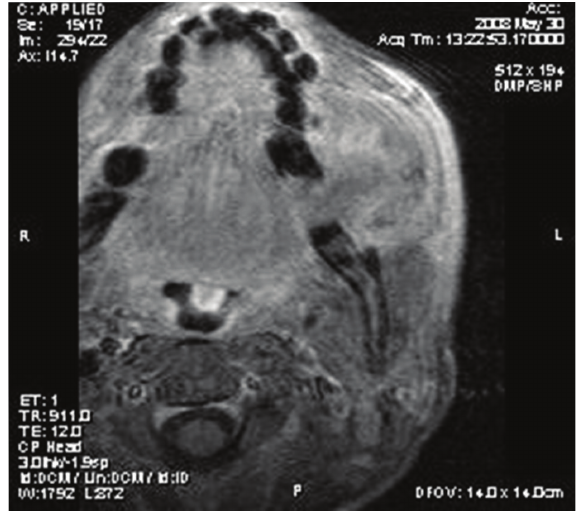
Figure 5: Postcontrast T 1 -weighted axial image showing heteroge- nous enhancement.